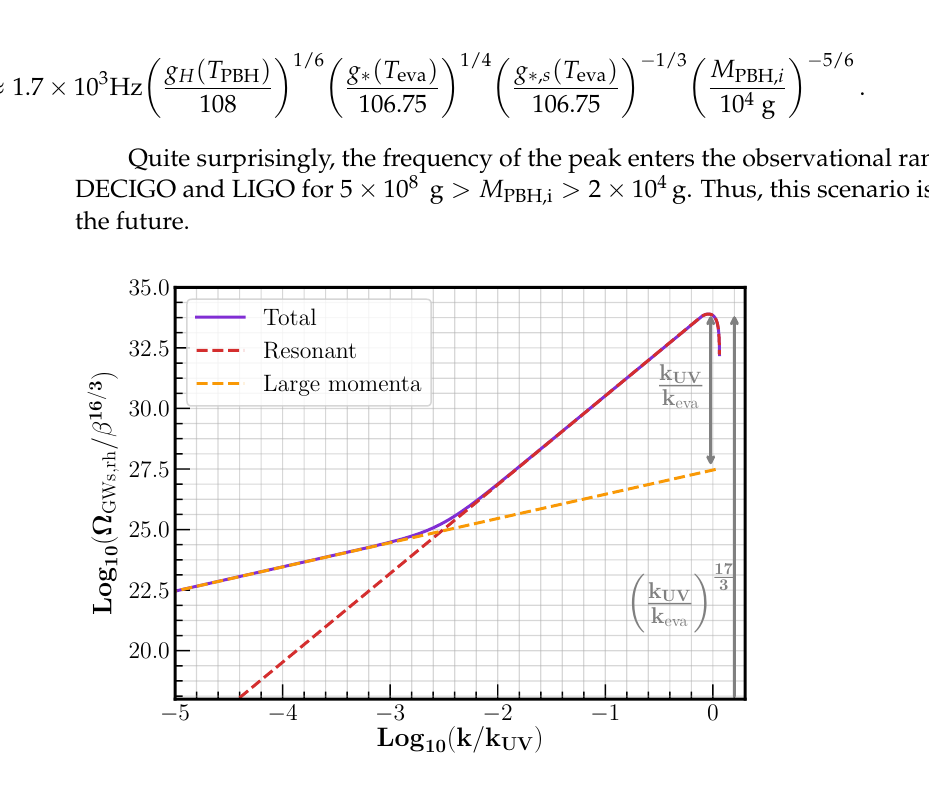
Figure 8. Induced GW spectral density after PBH evaporation normalized by β 16/3 and in terms of co-moving wavenumber k / k UV . The dashed red line shows the resonant contribution from Equation (154) . The dashed orange line is the large momentum contribution which can be found in [70]. The purple line is the total GW spectrum. Due to the almost sudden transition the GW spectrum is amplified. This implies a very small initial fraction β of PBH not to overproduce induced